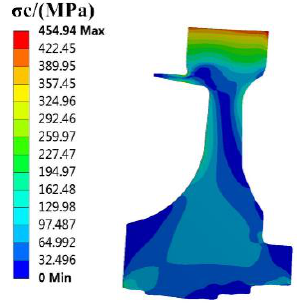
Materials 2019 , 12 , x FOR PEER REVIEW Figure 6. Distribution of disk creep stress. Figure 6. Distribution of disk creep stress. Figure 6. Distribution of disk creep stress. Figure 6. Distribution of disk creep stress.